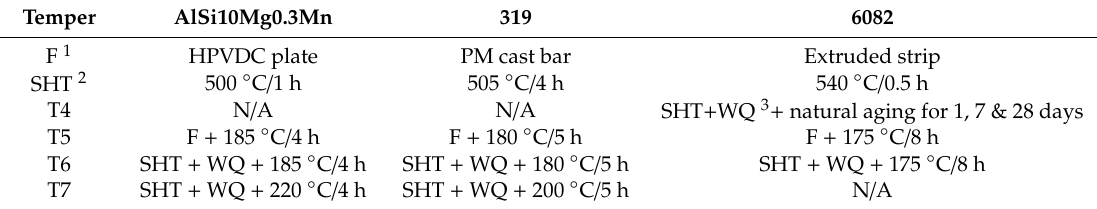
Table 2. Various heat treatments applied to the experimental